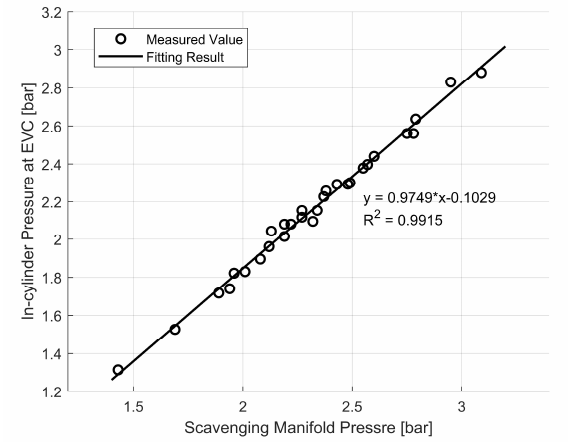
Figure 18. Fitting result between scavenging manifold pressure and in-cylinder pressure at EVC based on measured data.